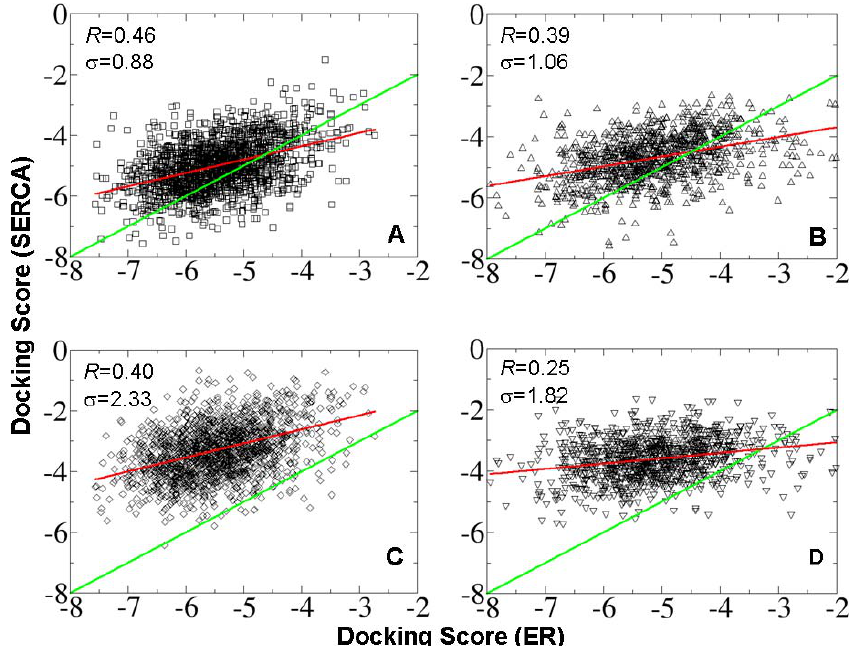
Figure 8. Correlation of Binding Affinity Scores by Docking Molecular Analogs of N-Moiety and C-Moiety of SERMs to ER a and SERCA Proteins (A,B) N- and C-moieties to ER a and SERCA TG1 sites, respectively. (C,D) N- and C-moieties to ER a and SERCA BHQ site, respectively. The red line represents the linear regression of docking scores. The green line indicates the optimal score correlation between two identical binding sites. The docking score is from eHits [31]. Docking score correlations from Surfex [32] show the same trends although the absolute values are different (unpublished